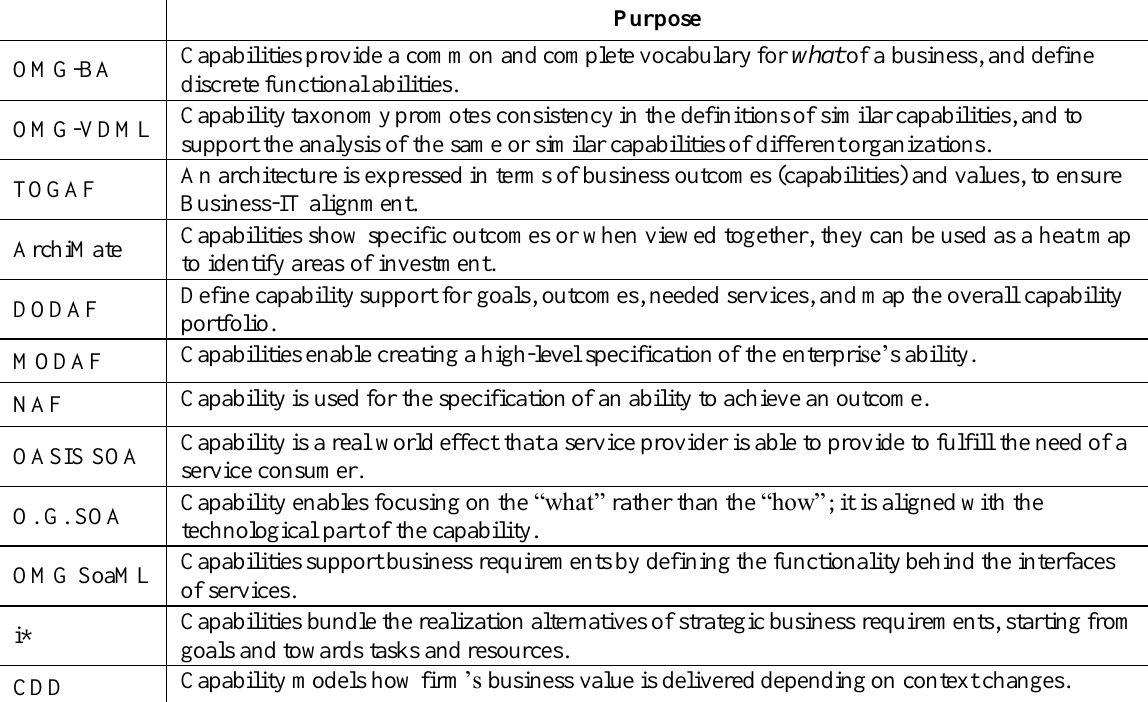
Table 5. The “Purpose” aspect of the capability concept